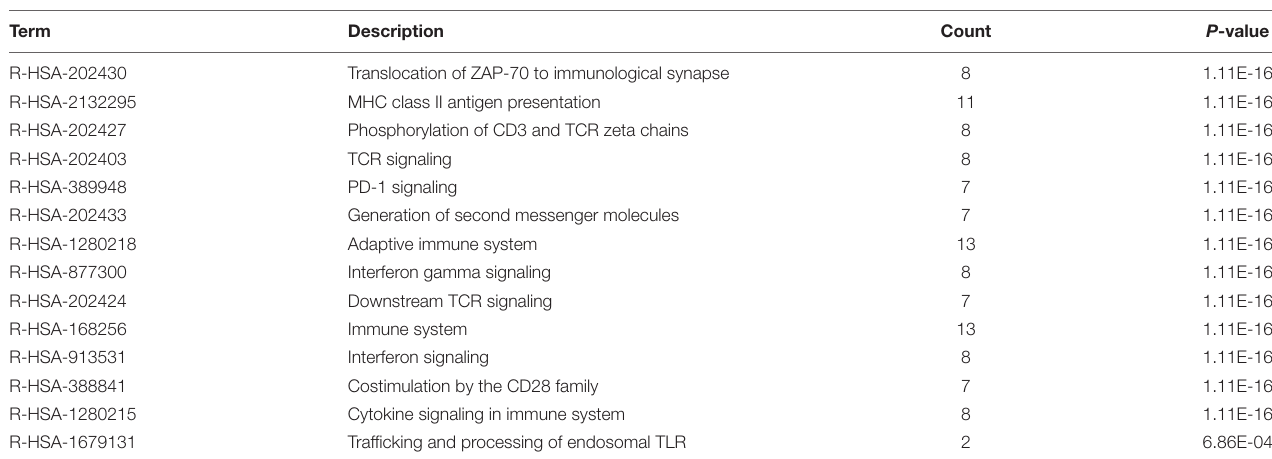
FIGURE 4 | The immune-associated functional enrichment analysis of downregulated DEGs. (A) Evaluation of immune system process of downregulated DEGs in ClueGo software. (B) Interrelation analysis between pathways in the BPs of downregulated DEGs. Each node represents a GO term, and lines reflect correlations between these terms. The node size is positively associated with term/pathway significance. The node color reflects the functional enrichment groups, with similar function clustering in same color. TABLE 3 | Pathway enrichment analysis of Module 1 genes